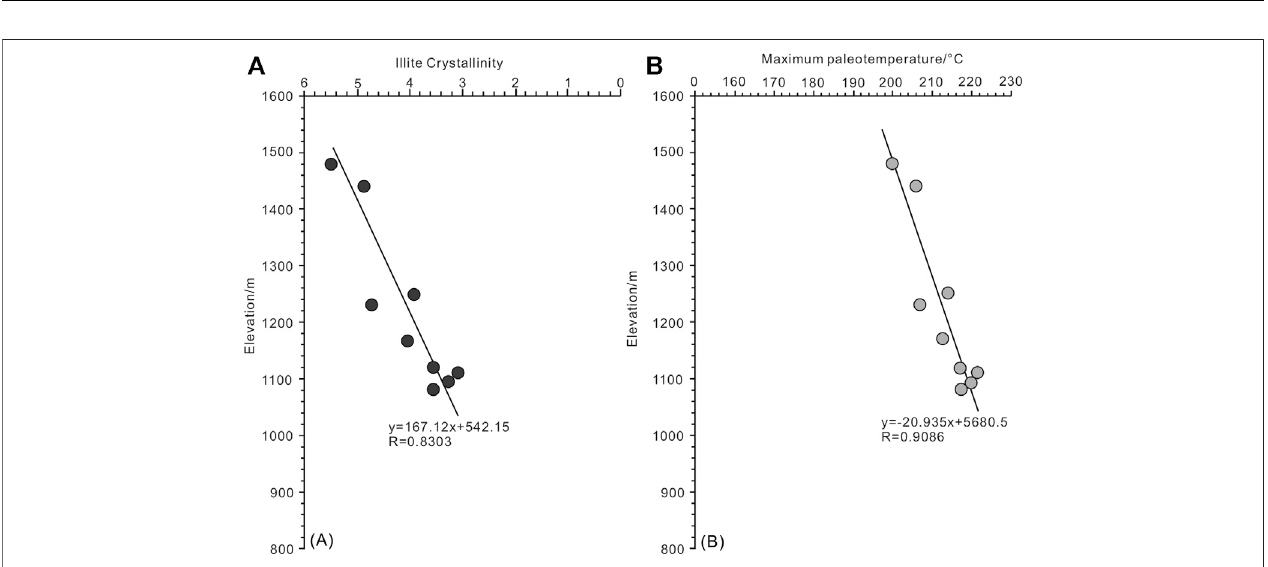
FIGURE 8 | Illite crystallinity, Illite crystallinity inversion of maximum paleotemperature and elevation map (A) Illite crystallinity and elevation map in central Qinshui Basin. (B) Maximum paleotemperature inverted by Illite crystallinity in central Qinshui Basin.